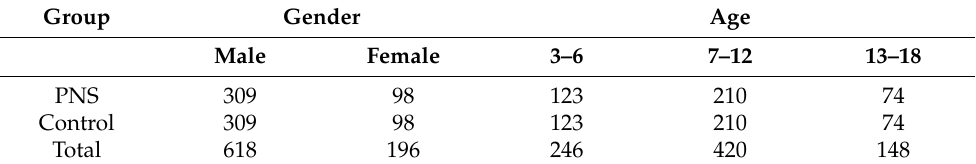
Table 1. Participants distributed by gender and